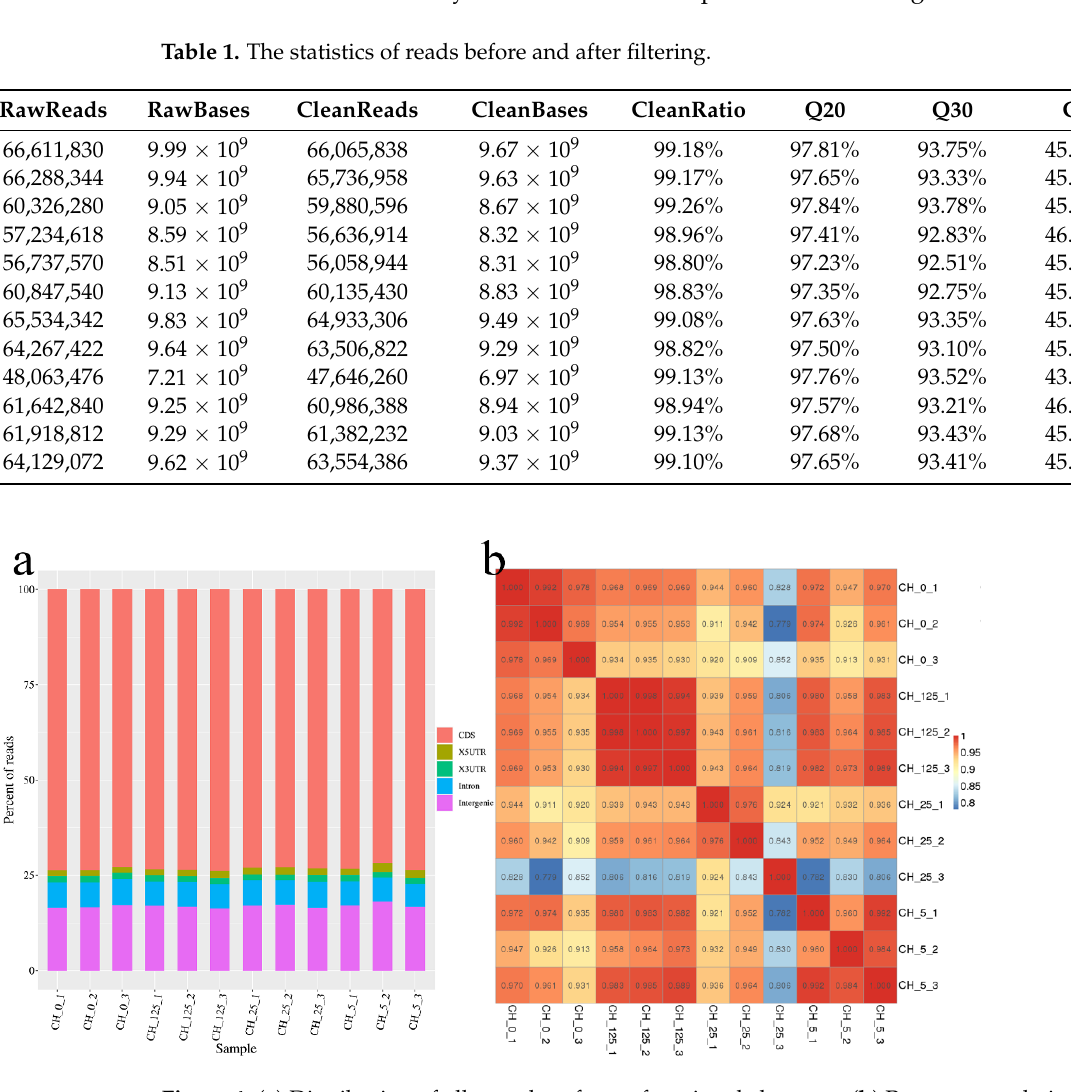
Figure 4. ( a ) Distribution of all samples of gene functional elements. ( b ) Pearson correlation coeffi- cients between samples.